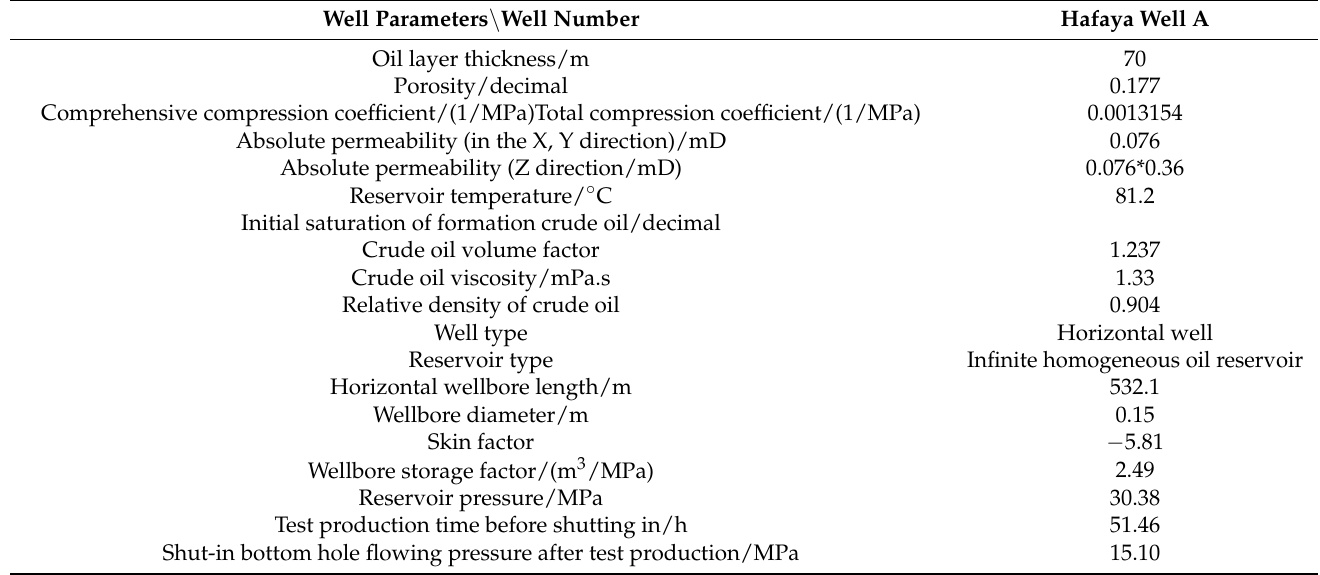
Table 10. Error analysis of the results of pressure recovery simulation calculation and test data. Project Average Relative Error (%) The Relative Standard Deviation (%) Simulation